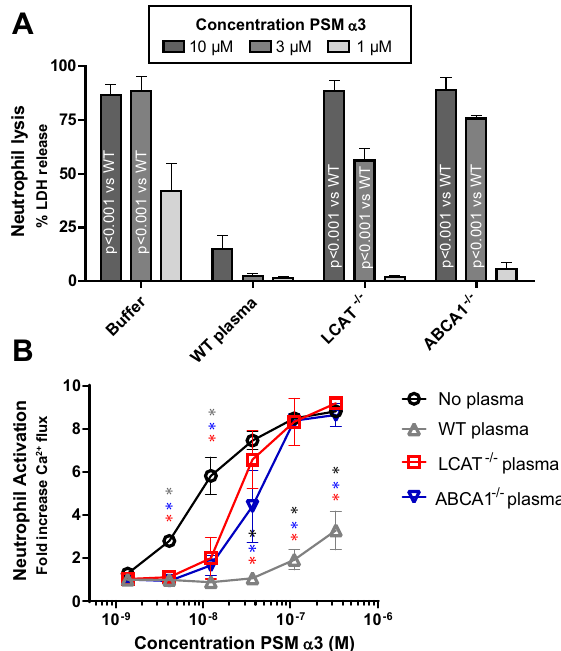
Figure 2. Reduced protection against PSM-mediated neutrophil activation and lysis by plasma from ABCA1 −/− or LCAT −/− mice. ( A ) Dose-dependent human neutrophil lysis by synthetic PSMα3 (10, 3 and 1 µM), preincubated with 0.5% plasma derived from WT(C57BL/6), ABCA1 −/− or LCAT −/− mice. Neutrophil lysis was measured through LDH release. Data represent means ± SEM of 4 independent experiments. ( B ) Dose–response curves for calcium mobilization in HL-60/FPR2 cells induced by PSMα3 preincubated with 0.1% plasma from WT, ABCA1 −/− or LCAT −/− mice. * indicates statistical significance of p < 0.01. At concentrations below 10 nM statistical significance was found between no plasma conditions and pretreatment with WT, ABCA1 −/− or LCAT −/− . Above 30 nM PSMα3 WT plasma was significantly different from ABCA1 −/− , LCAT −/− or no plasma. Data represent means ± SEM of 4–5 independent